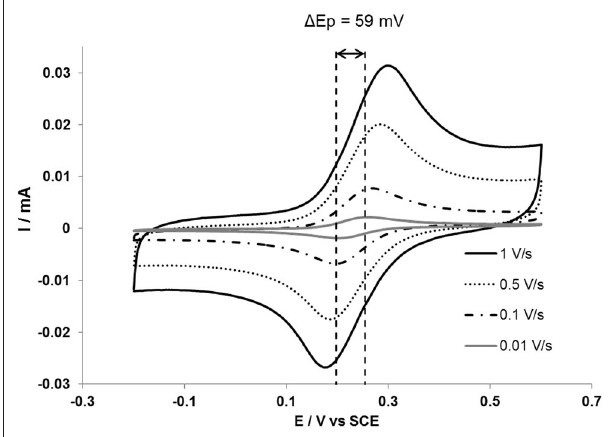
FIGURE 15 | Cyclic voltammograms of a 3D self-organized graphene of 0.5mM ferrocene dimethanol solution in 0.1M NaClO4 aqueous electrolyte. The two vertical dashed lines help read the theoretical 1 Ep value of 59mV (Reproduced from Fortgang et al. (2016) with permission of ACS Publications].